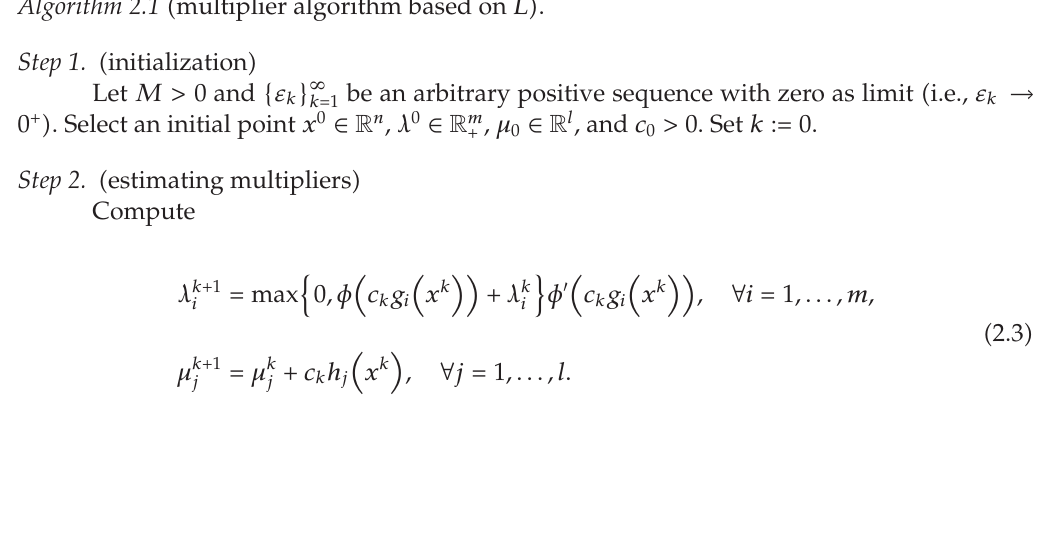
Algorithm 2.1 (cid:4) multiplier algorithm based on L (cid:5)